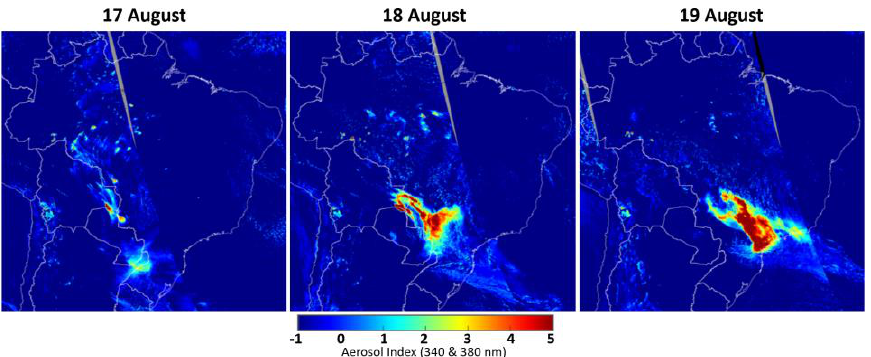
Figure 10. AI map values in Brazil, Paraguay, Bolivia, and northern Argentina and Uruguay from 17 to 19 August 2019. Such values were obtained from the OMPS-NM instrument on the Suomi-NPP satellite.